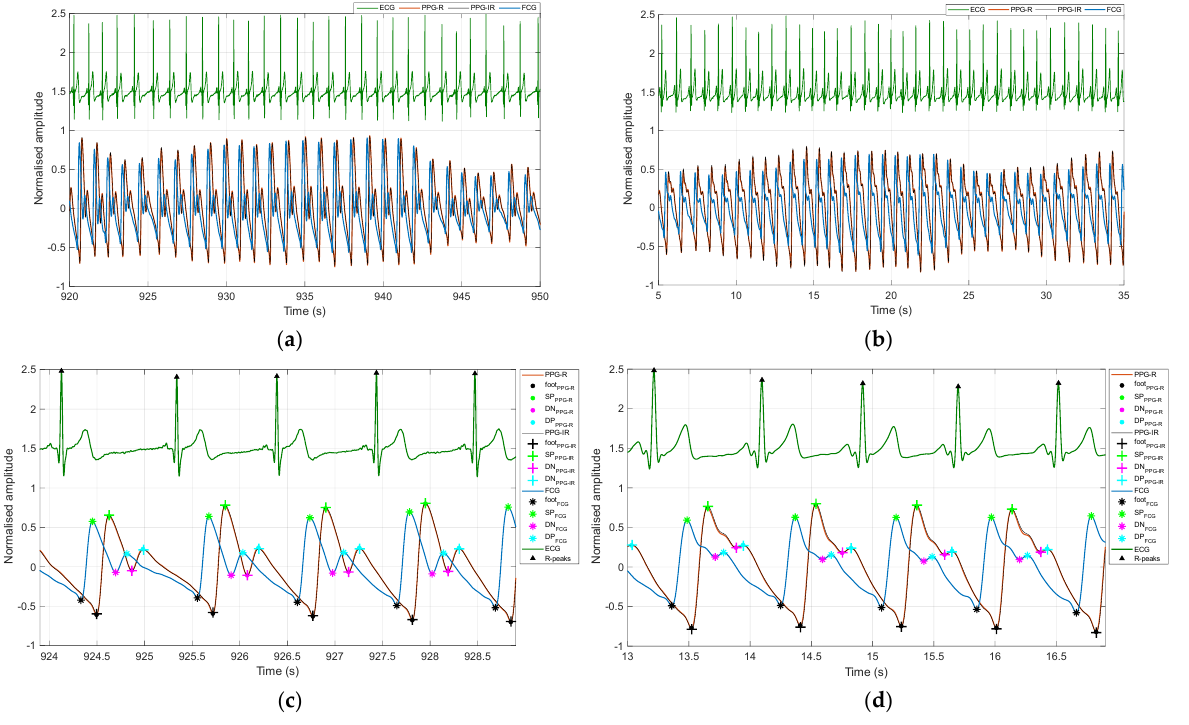
Figure 3. Example of PW signals acquired by the PPG sensor (red and infrared) and the piezoelectric FCG sensor, along with the concurrently acquired ECG lead I. ECG R-peaks and the four fiducial markers located in PW signals are also depicted. A delay between the PPG and FCG sensor signals can be clearly observed. ( a ) Signals acquired in subject #1; ( b ) signals acquired in subject #3; ( c ) detail on four heart beats from the signal shown in panel ( a ) with the localized fiducial markers; ( d ) detail on four heart beats from the signal shown in panel ( b ) with the localized fiducial markers.